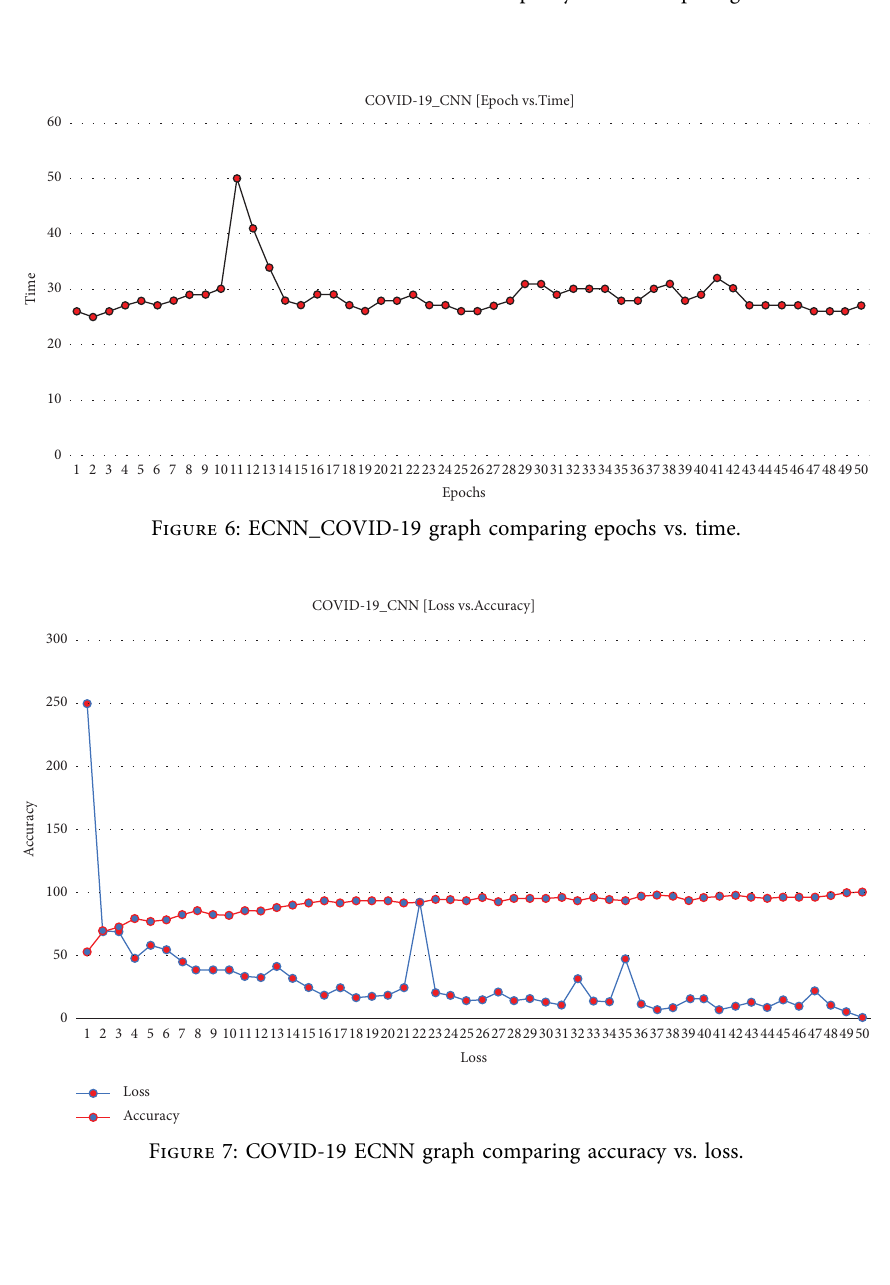
Figure 5: Processor and related resources occupancy of the computing device.